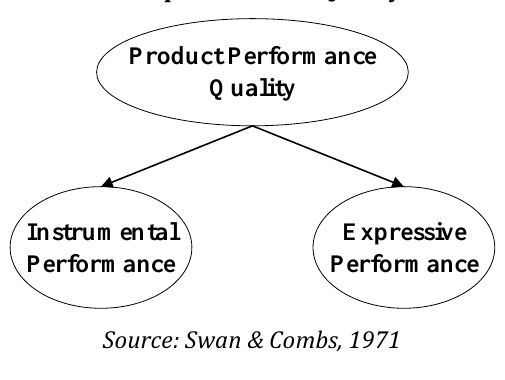
Figure 2: Product performance Quality Dimensions